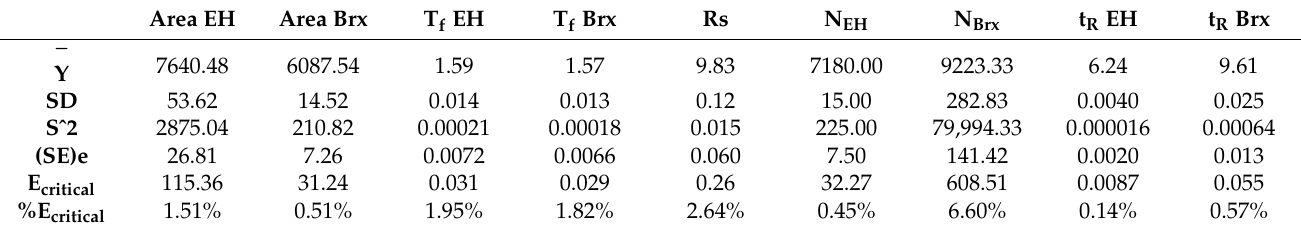
Table 7. The calculation of E critical and %E critical values for each response.